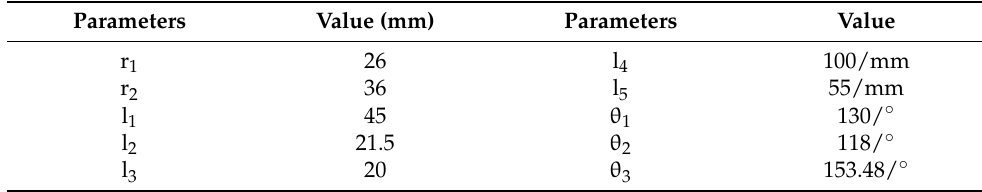
Table 1. Structure parameters of manipulator mechanism.